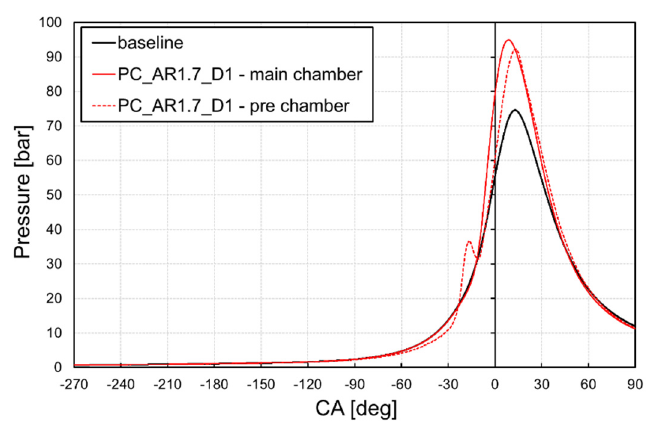
Figure 8. Comparison between simulated pressure traces during compression and combustion phases (dashed line: pre-chamber pressure, solid line: main combustion chamber pressure).